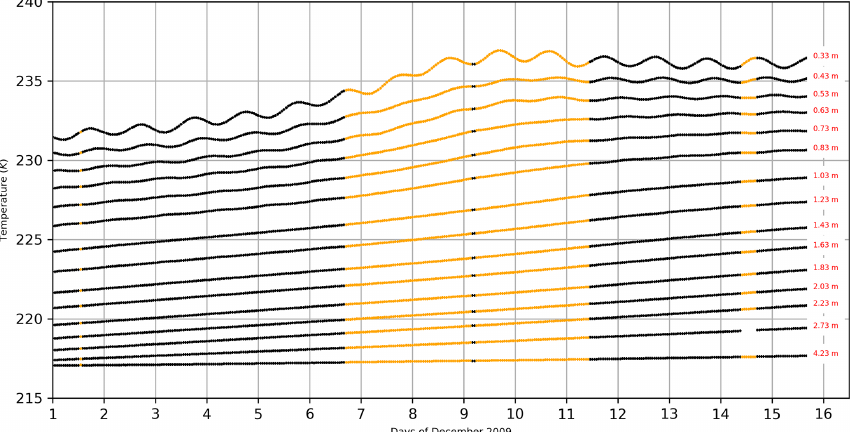
Figure 3. Temperature measurements in the snowpack as a function of depth. The black dots represent the in situ measurements and the orange dots are the data reconstructed with the CROCUS